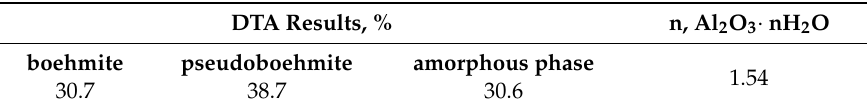
Table 7. Results of di ff erential thermal analysis.